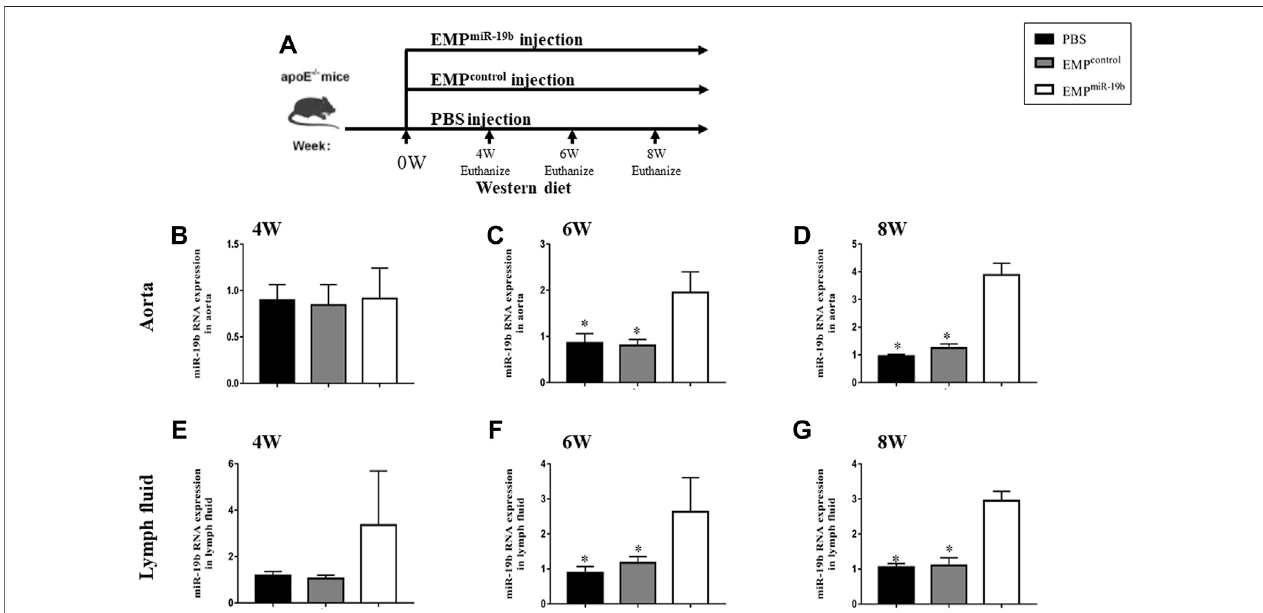
FIGURE 2 | miR-19b levels in different tissues from mice in the three treatment groups after 4, 6, and 8 weeks of treatment. (A) Schematic of the experimental procedureforEMPorcontrltreatmentanddifferentobservation points. (B) After4and 6 weeks (C) and8 weeks (D) oftreatment, miR-19blevelsinaortictissue ofmice injected with the indicated EMPs. * p < 0.05 compared with EMP miR-19b group, n = 7 – 8 per group. (E) After 4 and 6 weeks (F) and 8 weeks (G) of treatment, miR-19b levels in lymph fl uid of mice injected with the indicated EMPs. * p < 0.05 compared with EMP miR-19b group, n = 7 – 8 per group.